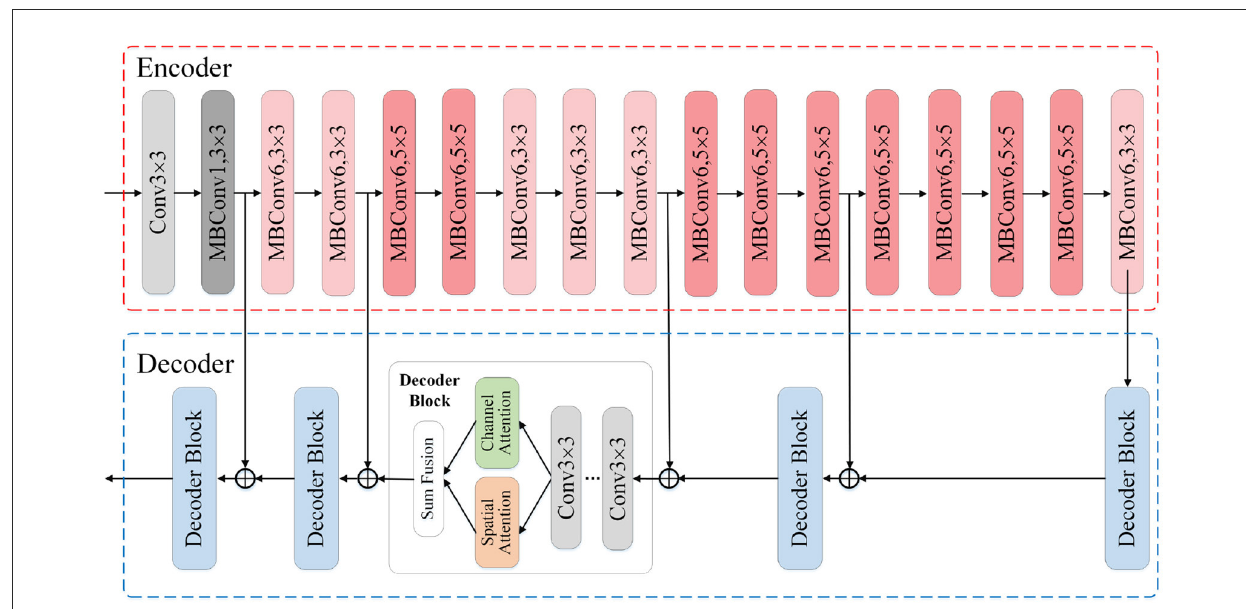
FIGURE3 Illustration of the segmentation module architecture. The input is the original images or the ones translated by image translation module, and the output is the segmentation result. The encoder adopts EfficientNet-B0 as the feature extraction skeleton. In the decoder we incorporate the hybrid attention mechanism and skip connection